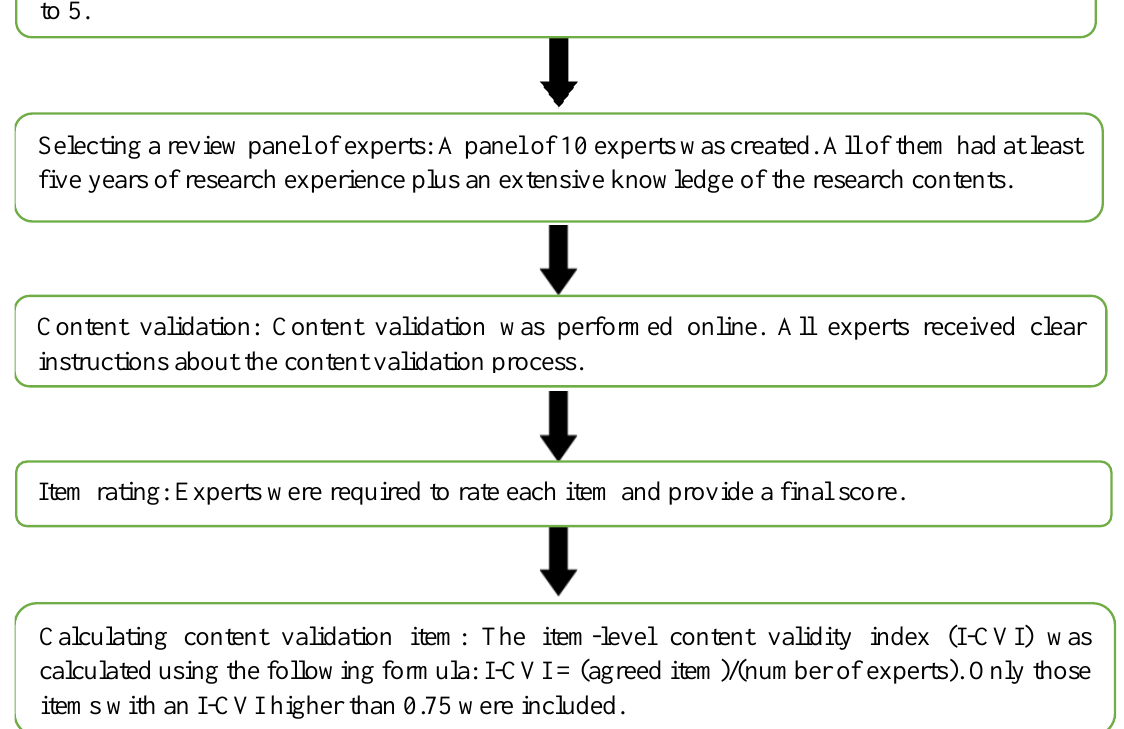
Figure 2. Questionnaire validation steps.